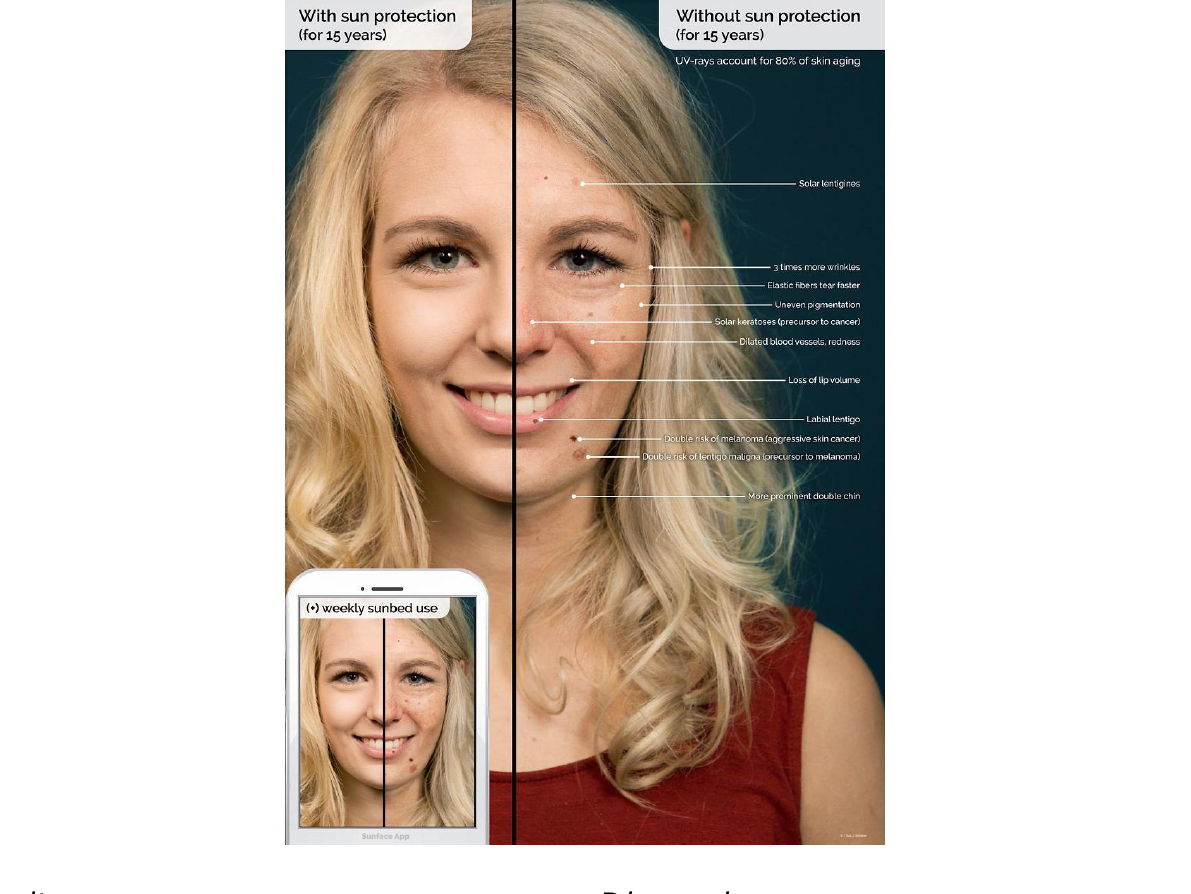
Figure 5. Explanatory graphic within the app explaining the shown effects. UV: